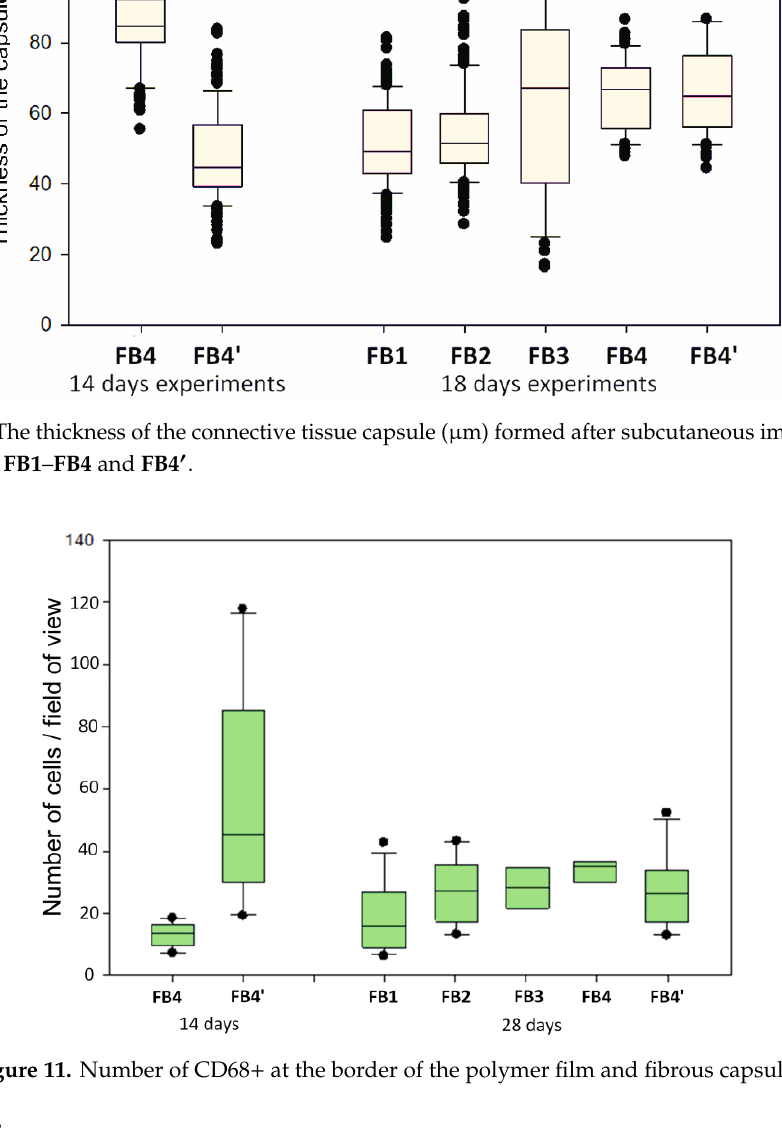
Figure 10. The thickness of the connective tissue capsule (μm) formed after subcutaneous implantation of the films FB1 – FB4 and FB4 ′ .